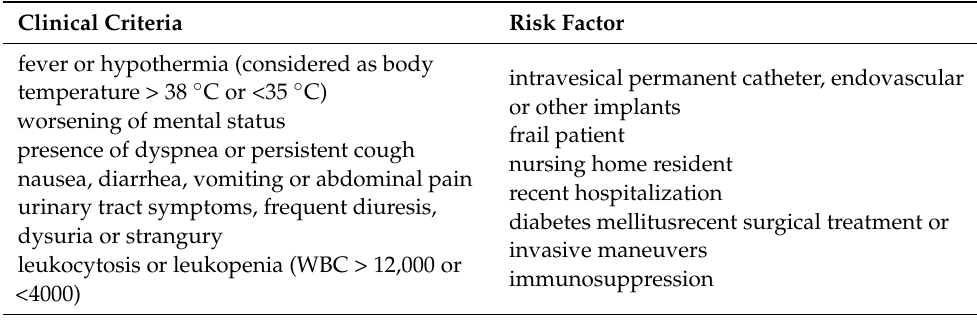
Inclusion Criteria: 2 Clinical Criteria or 1 Clinical Criteria + 1 Risk